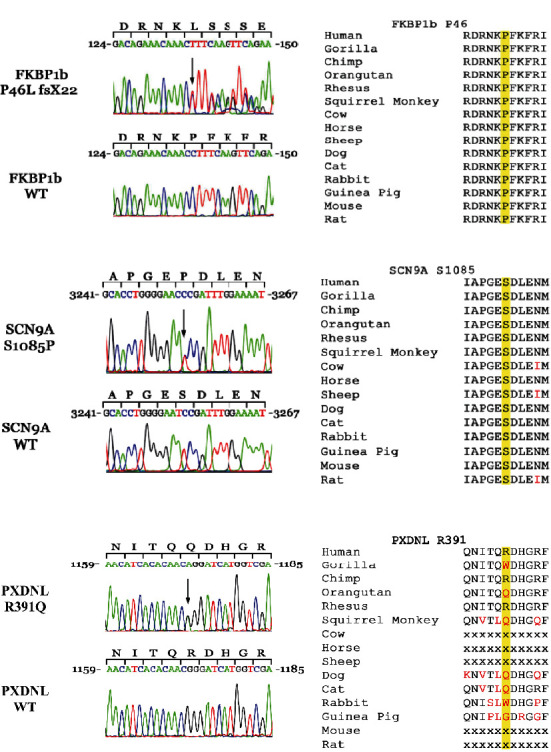
DNA sequencing analysis of SCN9A and FKBP1b. The FKBP1b gene was mutated to a C deletion at location 137 in exon 3 resulting in complexed amino acid changes. The amino acid change was proline to leucine at position 46; the next 22 amino acids were framed shifted culminating in a stop codon 22 amino acides downstream (P46L fsx22). The SCN9A gene was mutated from a T to C substitution at position 3253 in exon 17, resulting in an amino acid change from serine to proline at position 1085 (S1085P). The PXDNL gene was mutated from a G to A at position 1172 in exon 14, resulting in an amino acid change from arginine to glutamine at position 391 (R391Q). Mutations in SCN9A and FKBP1b are highly conserved across the various species. PXDNL is only expressed in certain mammals including primates.